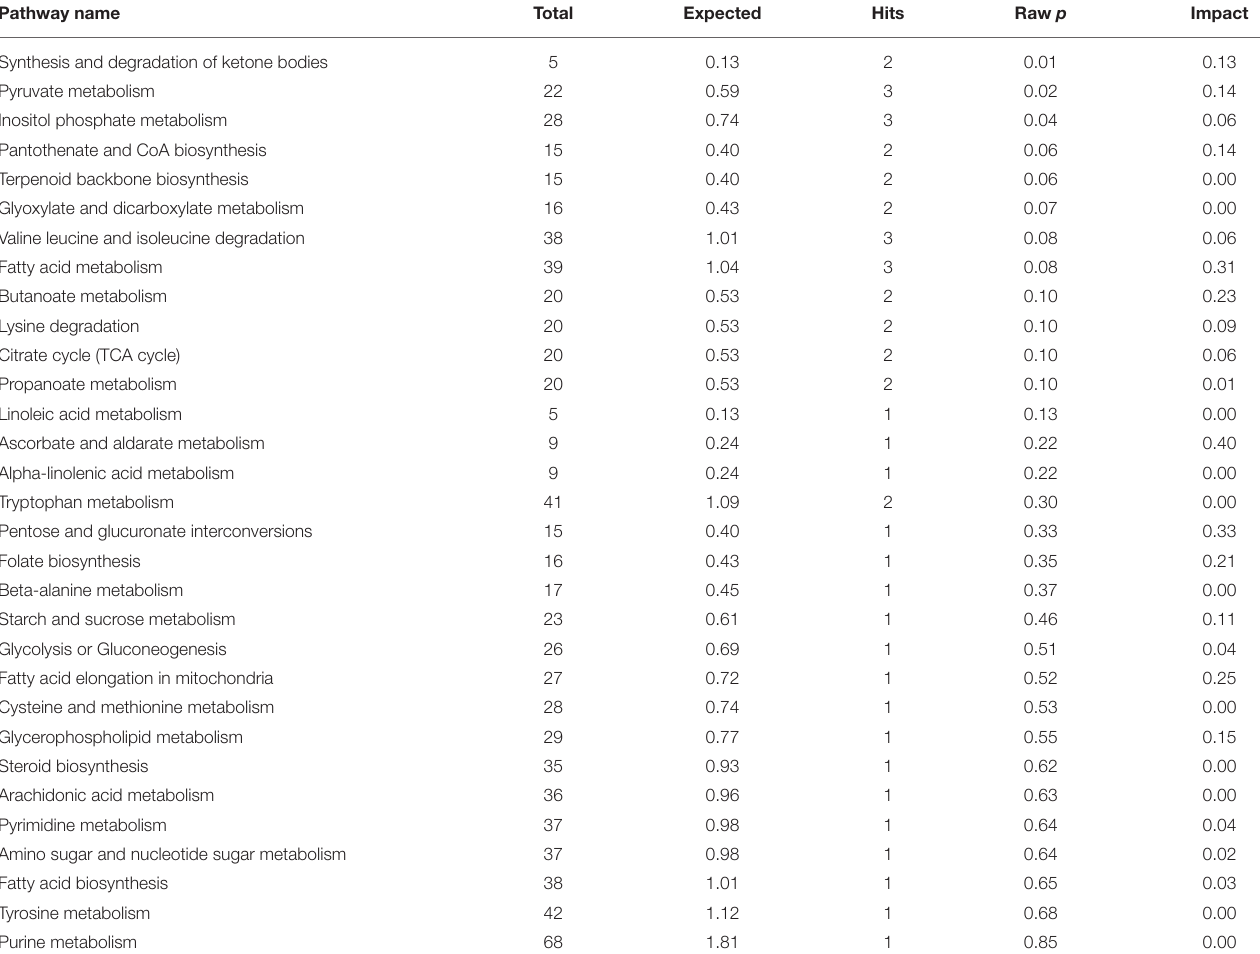
TABLE 3 | Enrichment of pathways involved in unique metabolites of seminal plasma in astheno-oligozoospermia bulls.